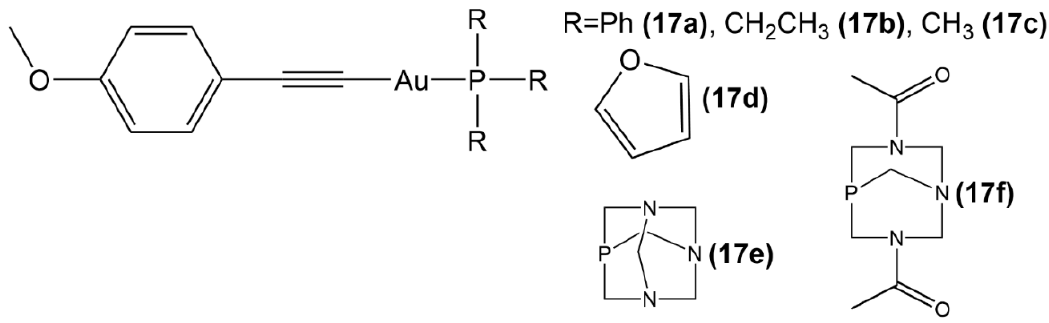
Figure 12. Gold(I) phosphine complexes ( 17a – 17f ). Novel gold(I) complexes containing tertiary phosphine and the new ligands 5-adamantyl- 1,3-thiazolidine-2-thione, 3-methyladamantane–1,3,4-oxadiazole-2-thione (Figure 13,